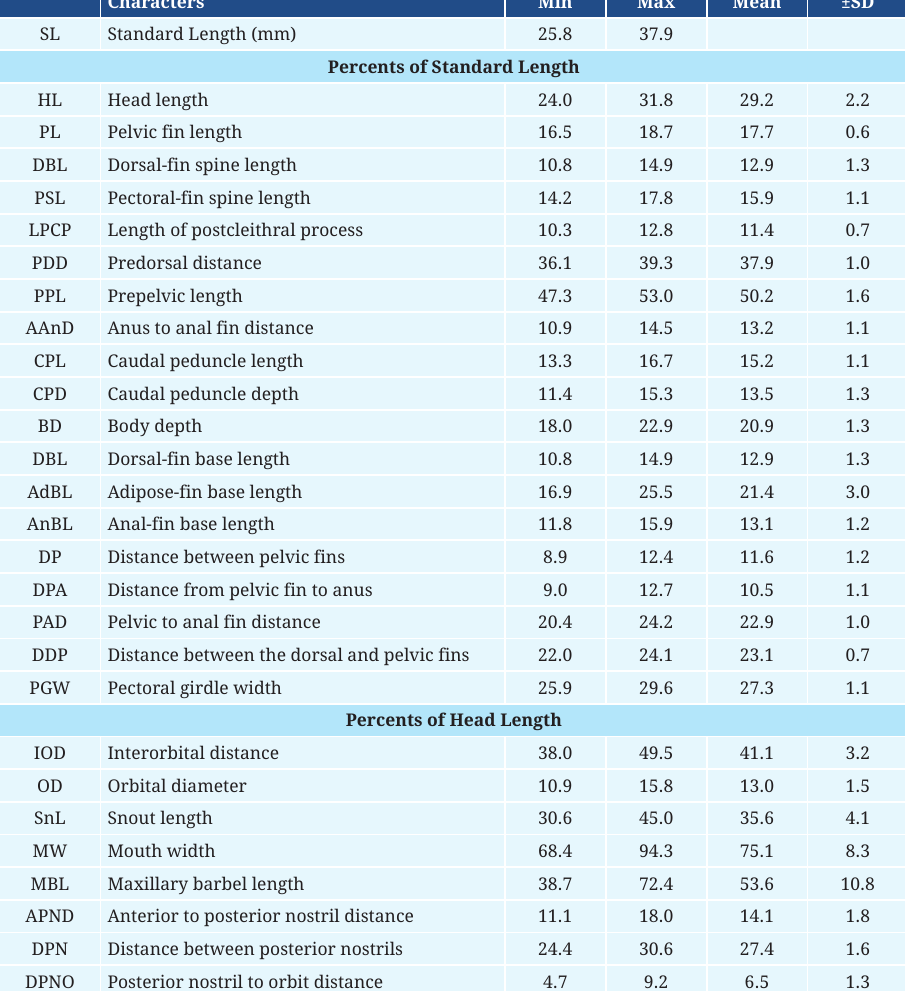
TABLE 2 | Morphometric data of newly captured specimens of Microglanis variegatus , expressed as percentages of standard length and percentages of head length, n = 12 (SD: standard